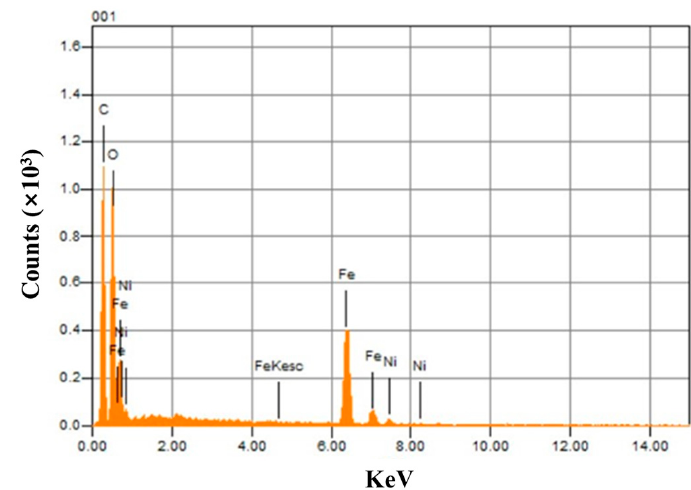
Figure 3. EDX spectrum of CS-NM bio-composite. Table 1. Elemental composition of CS-NM bio-composite.